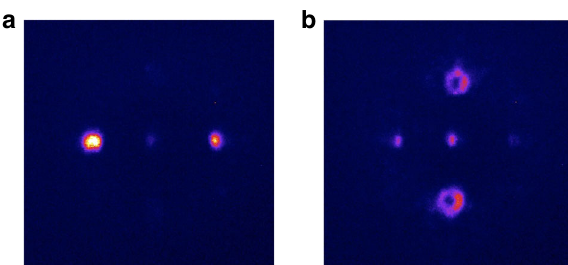
Fig. 5 Dynamic control over the second harmonic waves in a single 3D nonlinear photonic crystal. This is achieved by selectively exciting one- dimensional nonlinearity grating ( a ) and fork-type nonlinearity grating ( b ), that are located at different depths in the crystal and with 90° mutual azimuthal orientation. The separation distance between both patterns was approximately 322 μ